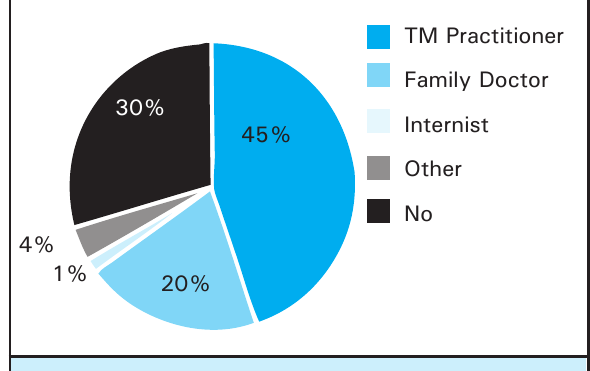
Figure 1. Pre-travel health assessment.